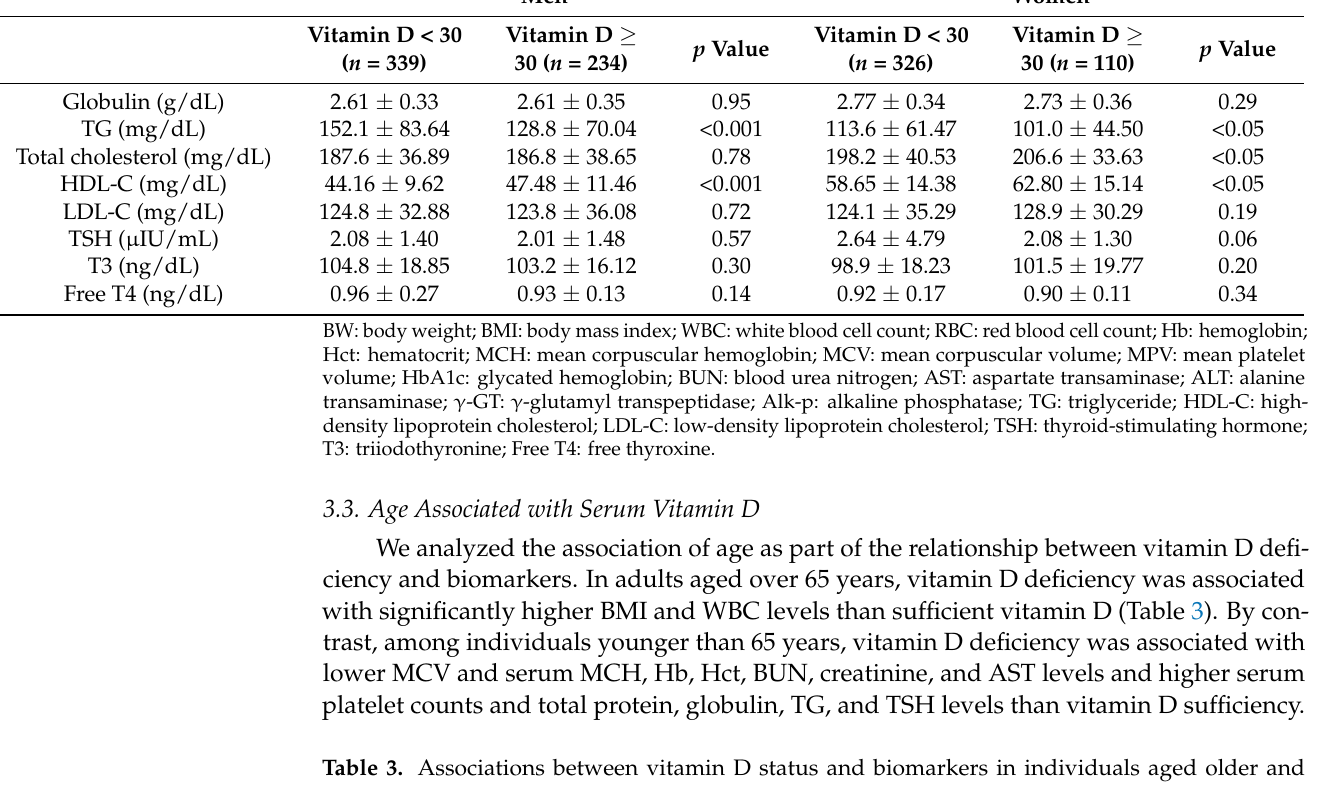
Table 3. Associations between vitamin D status and biomarkers in individuals aged older